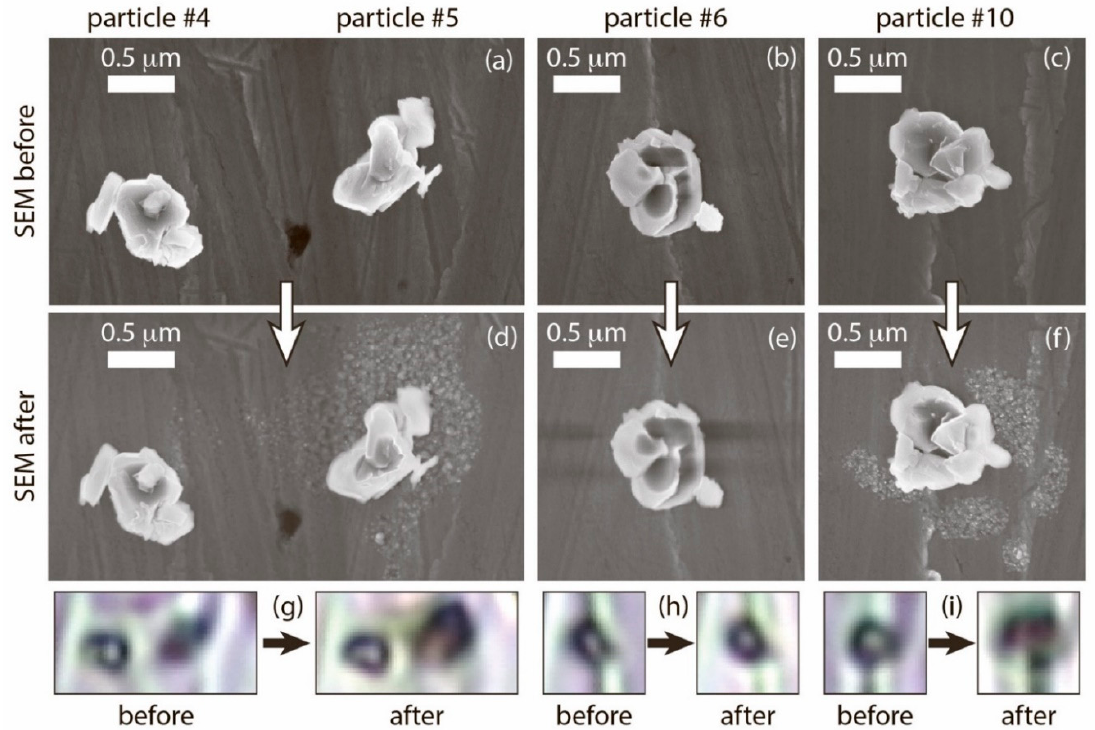
Figure 3. Particle morphology before and after the repeated action of laser irradiation, visualized by SEM ( a – f ) and optical microscopy ( g – i ). The images in the top row ( a – c ) were obtained before the initial Raman spectra measurements. The images in the middle row ( d – f ) were obtained after the repeated Raman spectra measurements. The height of the optical images in the bottom layer is 1.5 μ m. The arrows are directed from image of particles before laser action to image of the same particles after it.